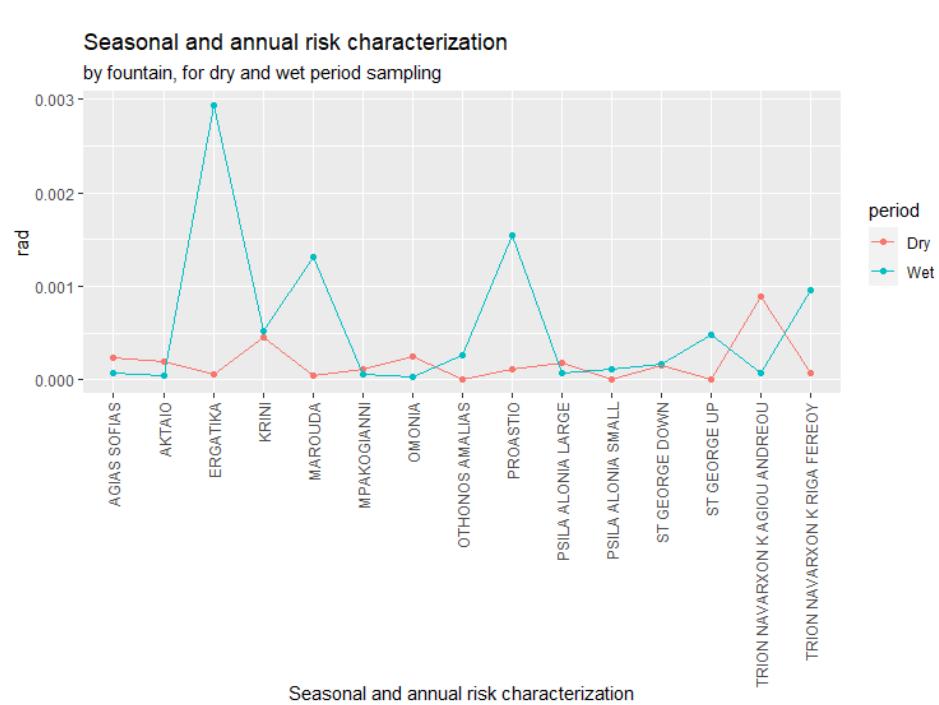
Figure 6. Legionella spp. seasonal risk characterization by fountain for wet and dry sampling